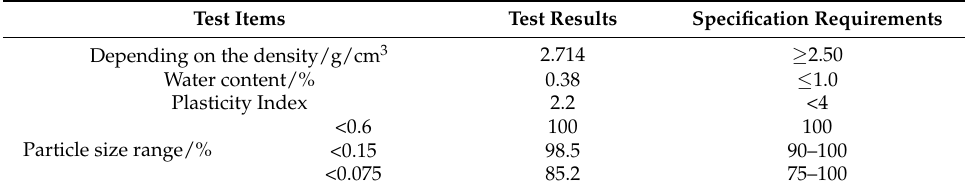
Table 2. Technical performance of the mineral